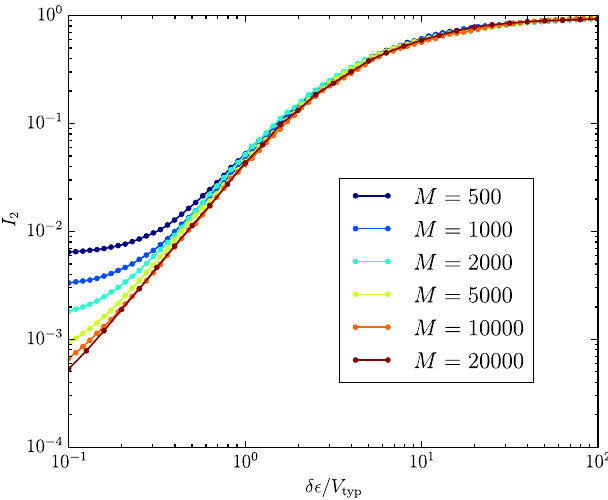
P jh i j ψ β ij 4 as a i for typ → 1 2